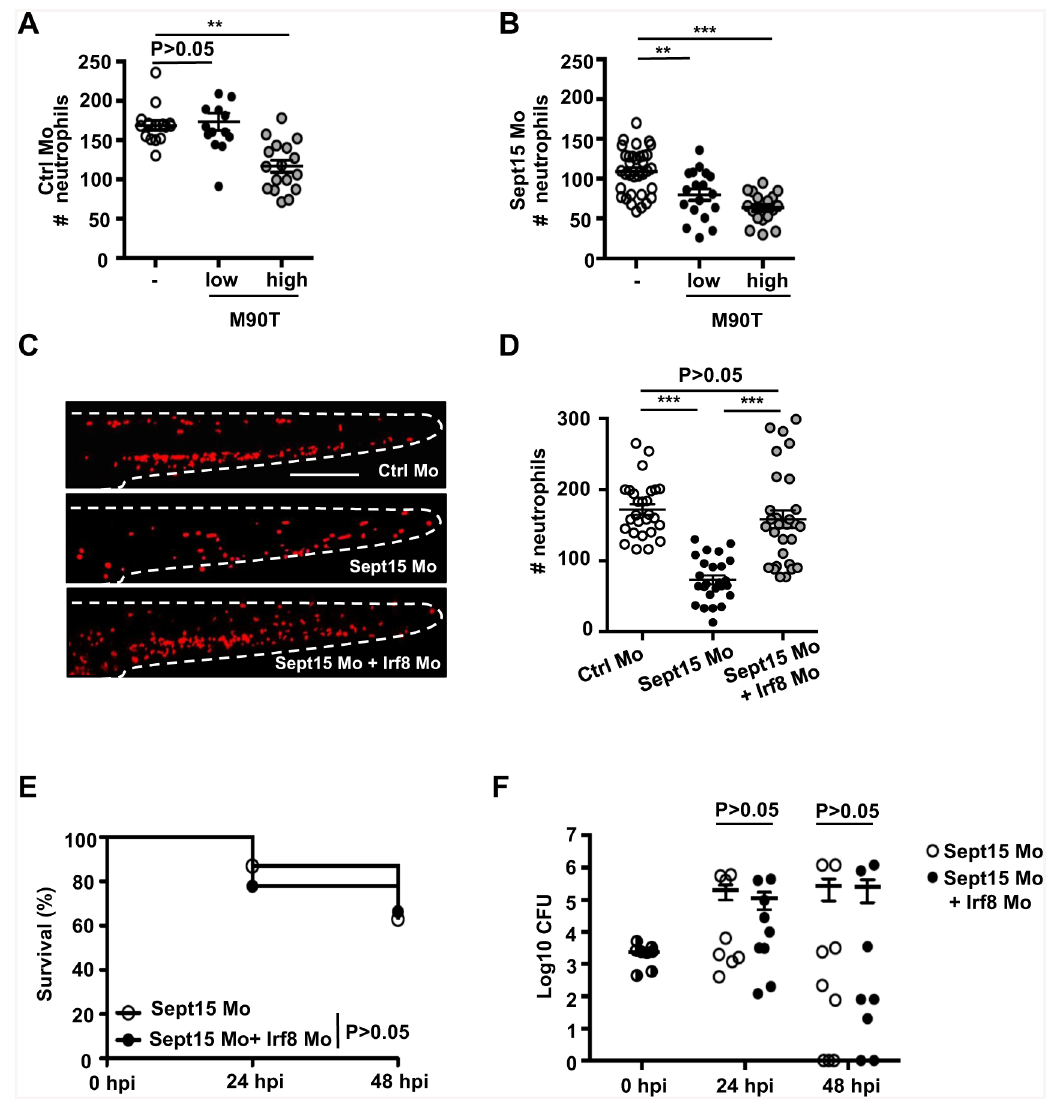
Fig 3. S . flexneri induces neutrophil death in Sept15 morphants. A-B. Quantification of neutrophilsin lyz :dsRed larvae injectedwith (A) Ctrl or (B) Sept15 morpholino (Mo), uninfected(open circles) or infected for 6 h with a low (closed circles) or high (grey circles) dose of S . flexneri M90T, from 4 or more larvae per treatment from 3 independent experiments. Circles represent individuallarvae. Mean ± SEM also shown (horizontal bars). Significance testing performed by ANOVA with Bonferroni posttest. ** , P < 0.01; *** , P < 0.001.C. Representative images of lyz :dsRedlarvae injectedwith Ctrl, Sept15, or Sept15 + Irf8 Mo. Scale bar, 250 μ m. D. Quantification of neutrophilsin lyz :dsRedlarvae injectedwith Ctrl (open circles), Sept15(closed circles), or Sept15 + Irf8 (grey circles) Mo. Circles represent individual larvae. Mean ± SEM also shown (horizontal bars). Significancetesting performed by ANOVA with Bonferroni posttest. *** , P < 0.001.E. Survivalcurves of Sept15 or Sept15 + Irf8 morphants infected with S . flexneri M90T (low dose). Pooled data from 3 independentexperiments per treatment using at least 15 larvaeper treatment. Significance testing performed by Log Rank test. F. Enumeration of bacteria at 0, 24, or 48 hpi from Sept15 (open circles) or Sept15 + Irf8 (closedcircles) morphants infected with S . flexneri M90T (low dose). Half-filledcircles represent enumerations from larvae at time 0 and are representative of inoculafor both conditions. Pooleddata from 3 independent experiments per inoculumclass using up to 3 larvae per treatment. Circles represent individuallarvae, and only larvae havingsurvived the infection(thus far) includedhere (i.e., dead larvae not homogenised for counts). Mean ± SEM also shown (horizontal bars). Significance testing performed by Student’s t test.